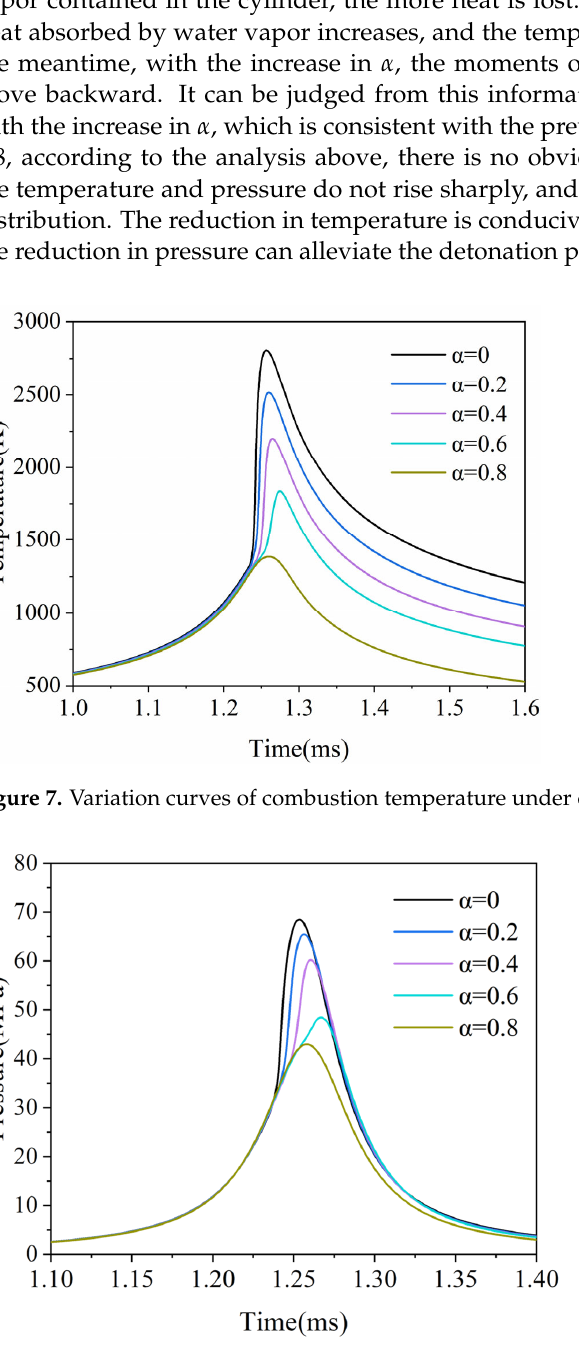
Figure 8. Variation curves of combustion pressure under different α .